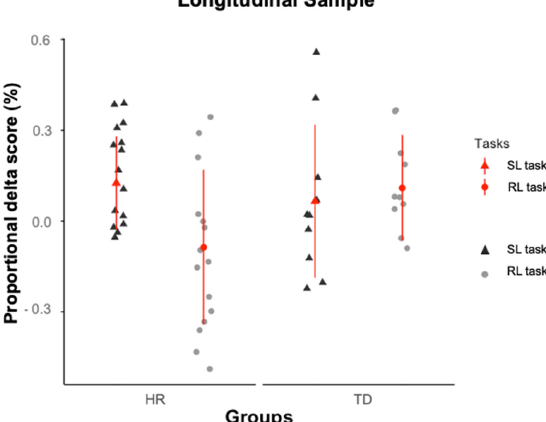
Figure 5. Individual data points of the proportional delta scores for the HR and the TD infants who